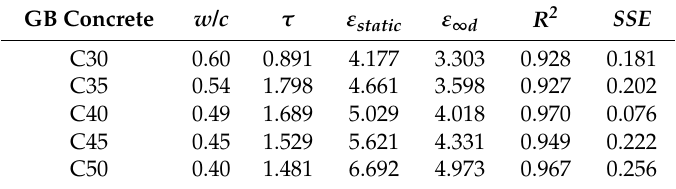
Table 5. Debye Model: Fitting Coefficients and Goodness of Fit for Equation (5). GB Concrete